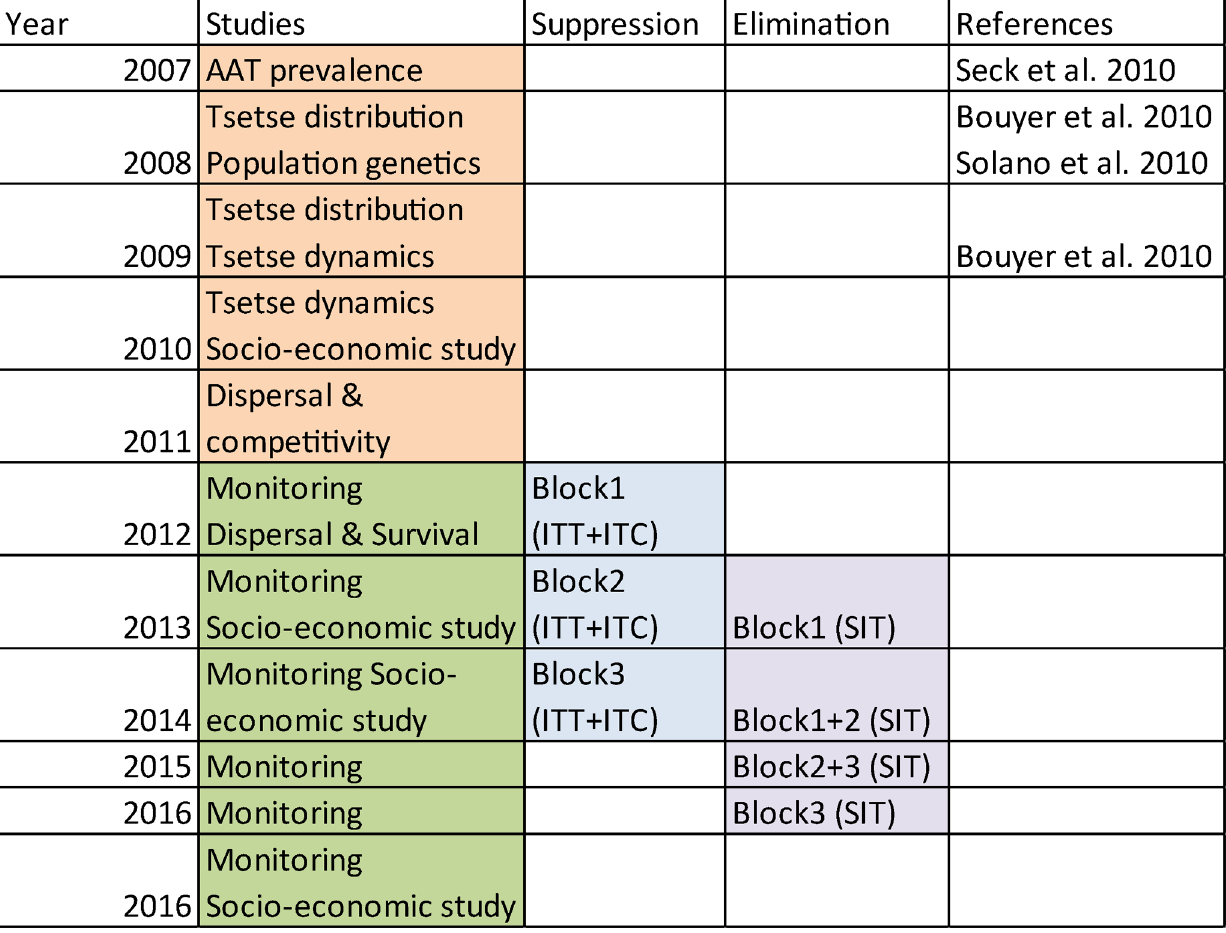
PLOS Neglected Tropical Diseases |